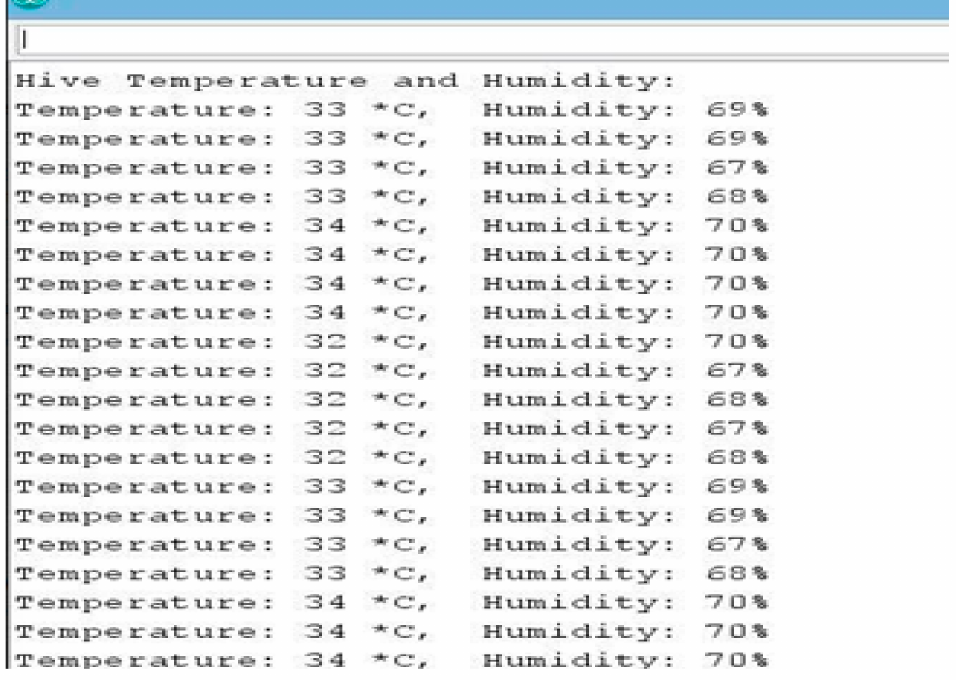
Figure 14. Temperature and humidity